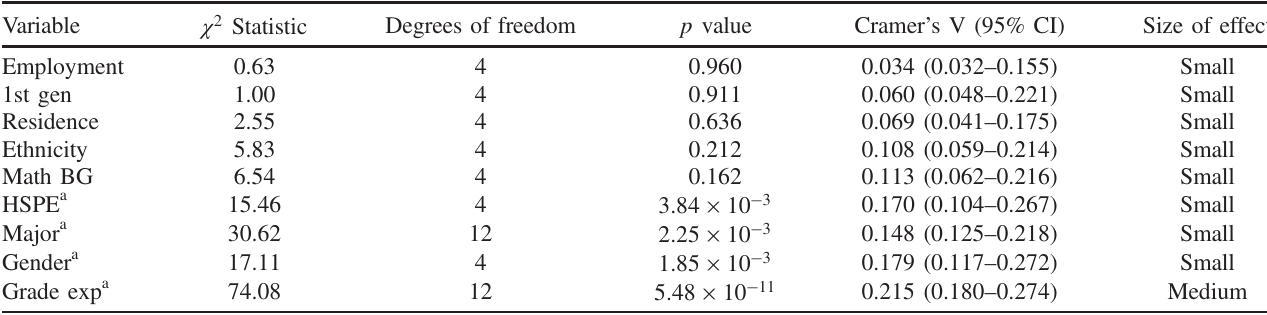
TABLE VII. Results of chi-squared tests for learning profile interactions with other categorical